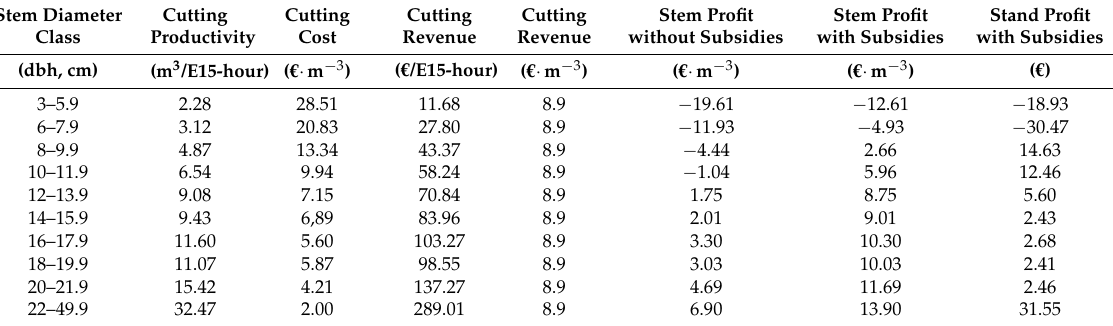
Table 2. Work-study parameters and profit calculations for each diameter class in a representative stand. Energy-wood cutting subsidies were 7 € ¨ m ´ 3 ; m 3 , cubic meters (solid volume, scaled outside the bark); dbh, diameter at breast height; E15-hour, operating hours, including delays shorter than 15